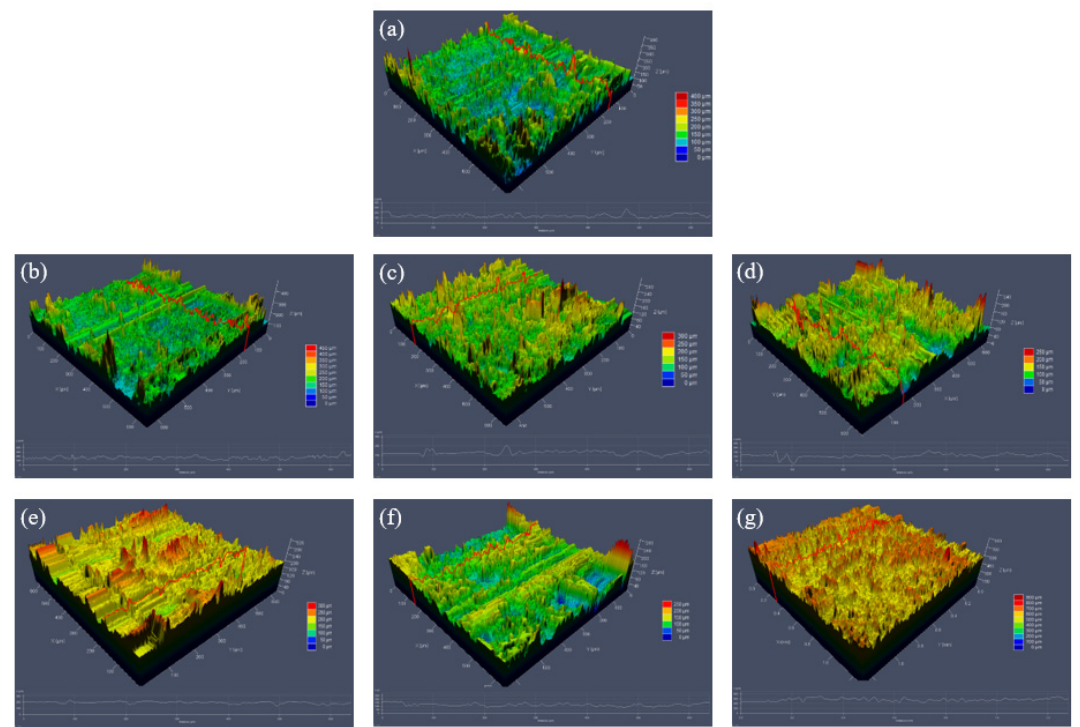
Figure 6. 3Dmorphology of MAO coatings: ( a ) S0; ( b ) S1; ( c ) S2; ( d ) S3; ( e ) S4; ( f ) S5; and ( g )